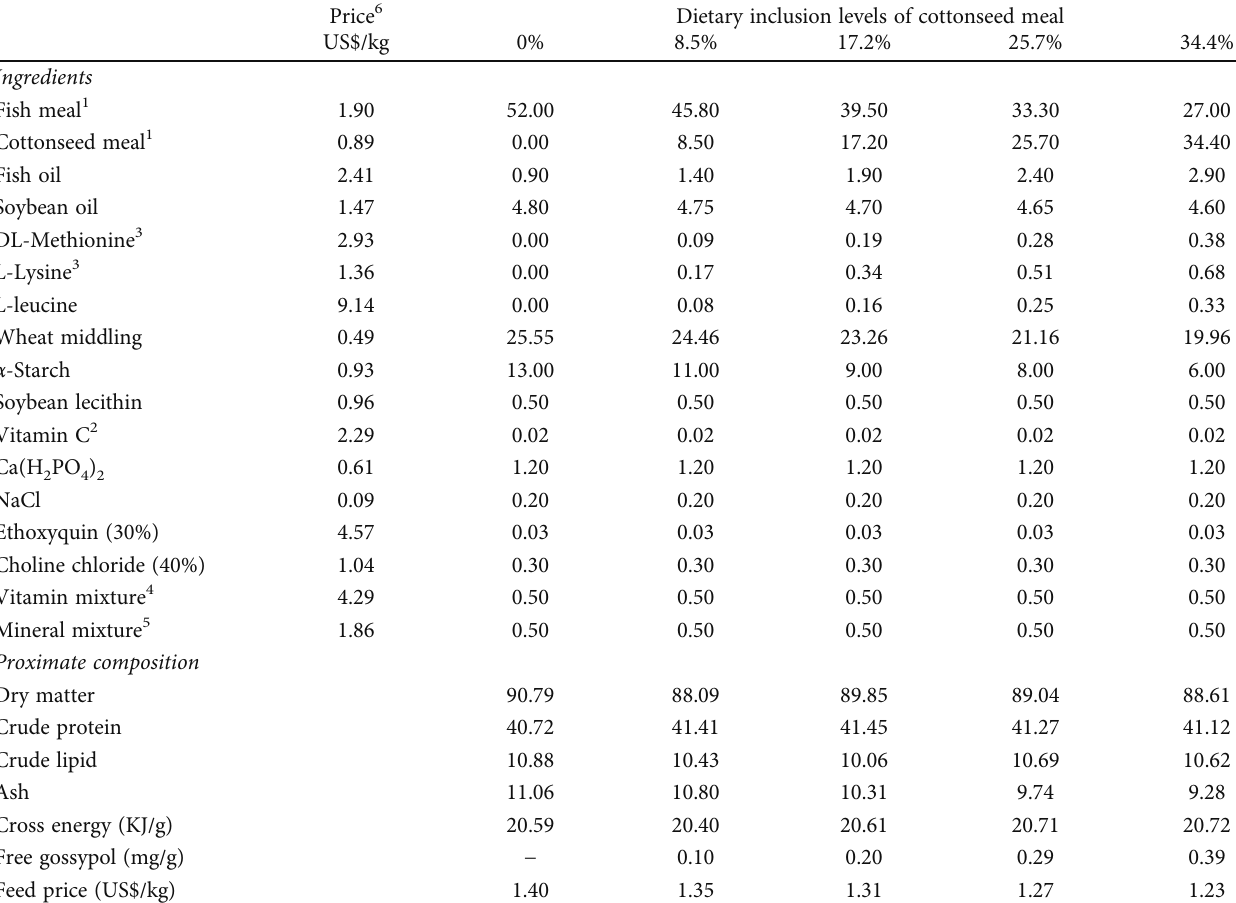
Table 1: Ingredients and proximate composition (% dry matter) of fi ve experimental